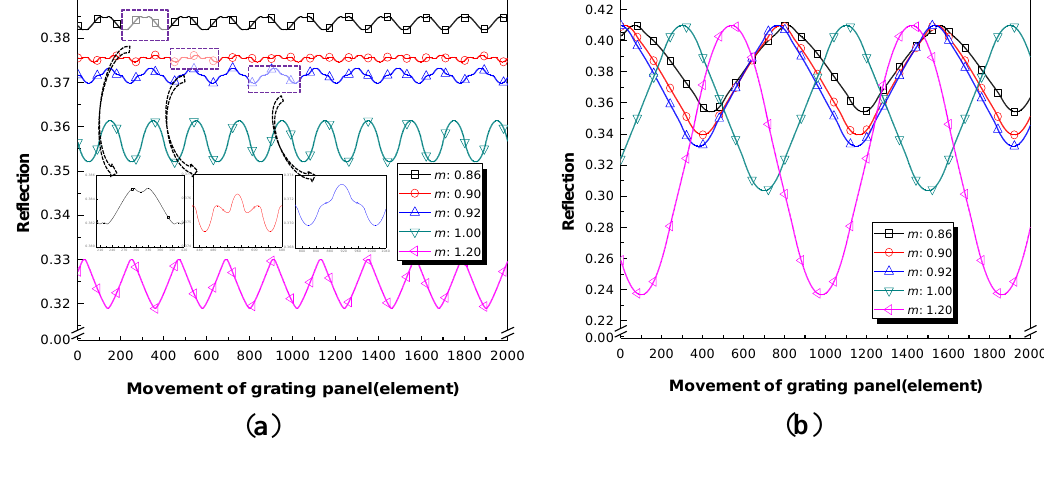
Figure 5. Variations of the reflective light according to different grating ratios (case 2). ( a ) Variations of the light depending on m when b 1 = 100 elements ; ( b ) Variations of the light depending on m when b 1 = 400 elements